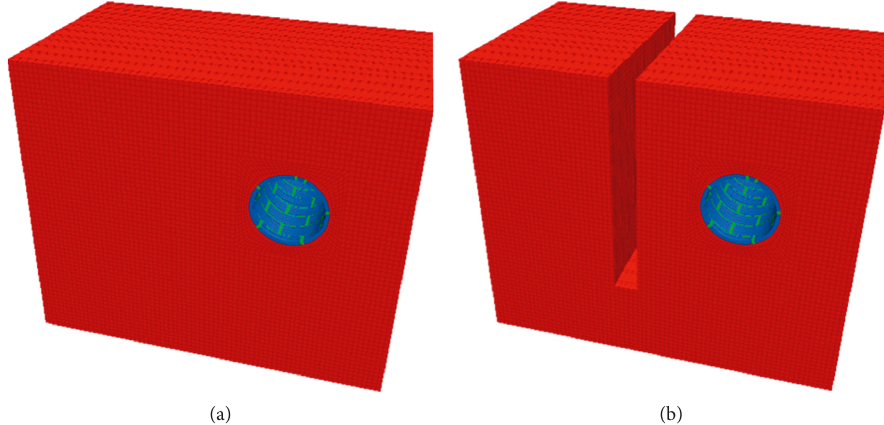
Figure 5: Illustration of the numerical model: (a) without the trench; (b) with the